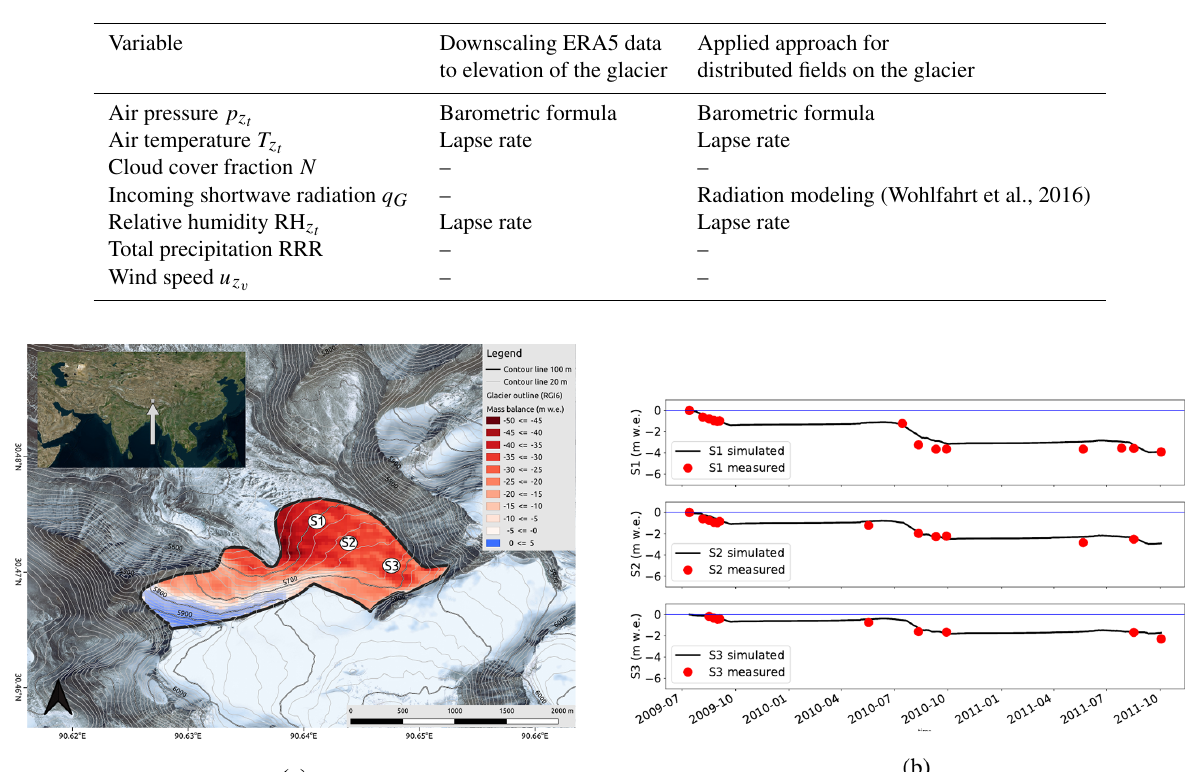
Table 2. COSIPY forcing variables and applied downscaling approaches for distributed simulation. RRR indicates total precipitation.